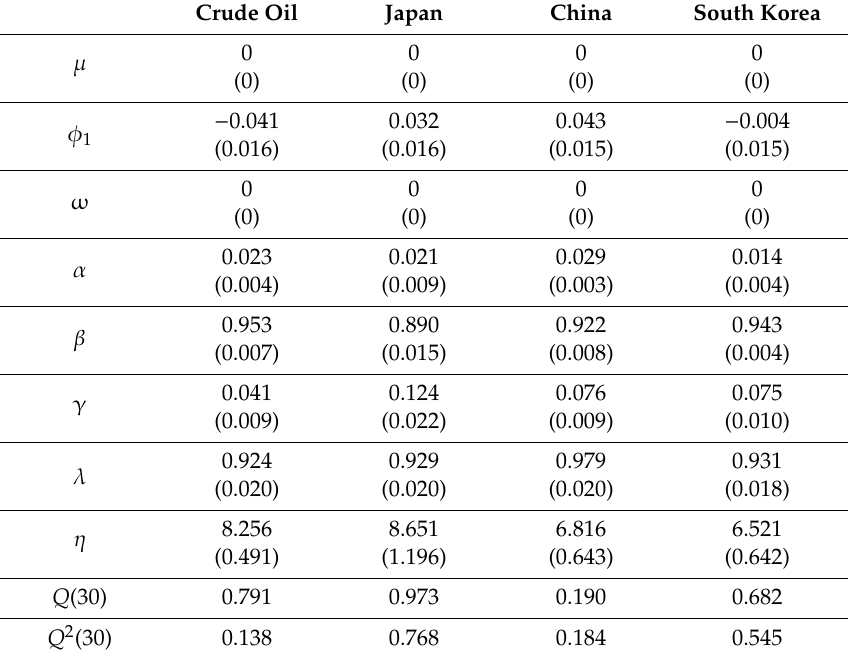
Estimates of marginal distribution from AR (1)-GJR-GARCH (1, 1, 1) with skewed-t distributions.